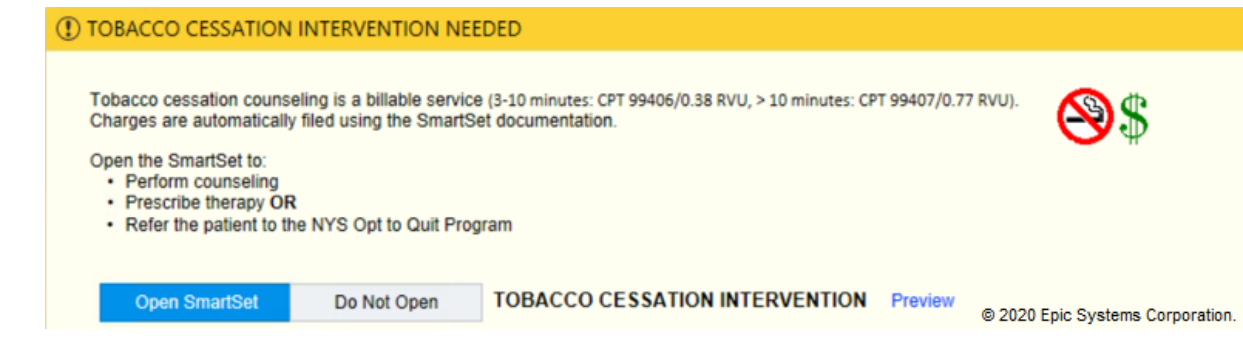
Figure 11. Tobacco financial messaging alert with both images (no smoking sign and dollar sign) tested in Round 3 of the randomized controlled trial. Copyright 2020, Epic Systems Corporation.